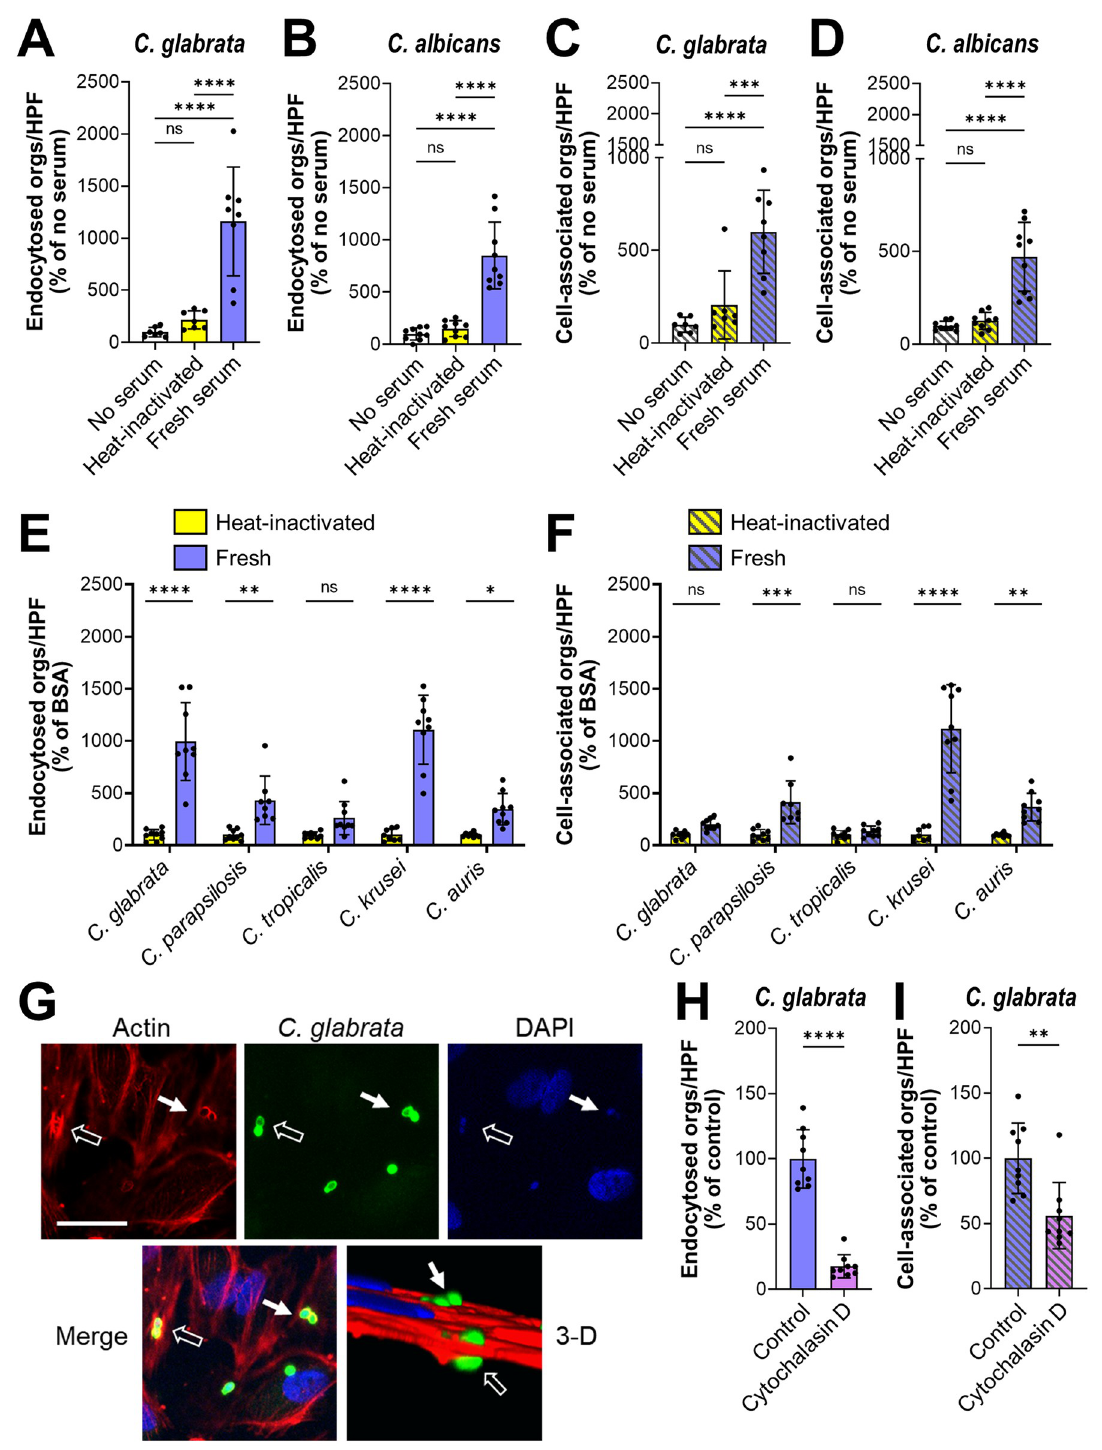
Fig 1. Serum coating increases the endocytosis of Candida spp . by human endothelial cells. (A-D), Effects of fresh and heat- inactivated human serum on the number of organisms that were endocytosed by and cell-associated (a measure of adherence) with human umbilical vein endothelial cells. (A) Endocytosis of live C . glabrata , (B) endocytosis of killed wild-type C . albicans yeast, (C) cell- association of live C . glabrata , (D) cell-association of killed wild-type C . albicans yeast. (E-F) endocytosis (E) and cell-association (F) of live cells of the indicated Candida spp . (G) Confocal micrographs showing the accumulation of phalloidin-stained endothelial cell actin